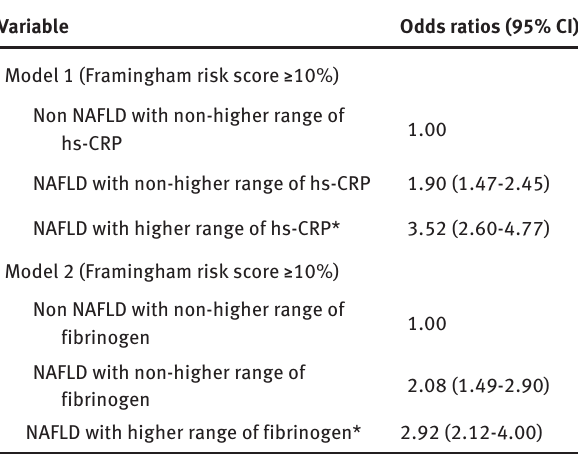
Table 3: Multiple logistic regression for the association between high ASCVD risk (Framingham risk score ≥10%) and NAFLD combined with the status of inflammatory markers (hs-CRP and fibrinogen) Variable Odds ratios (95% CI)